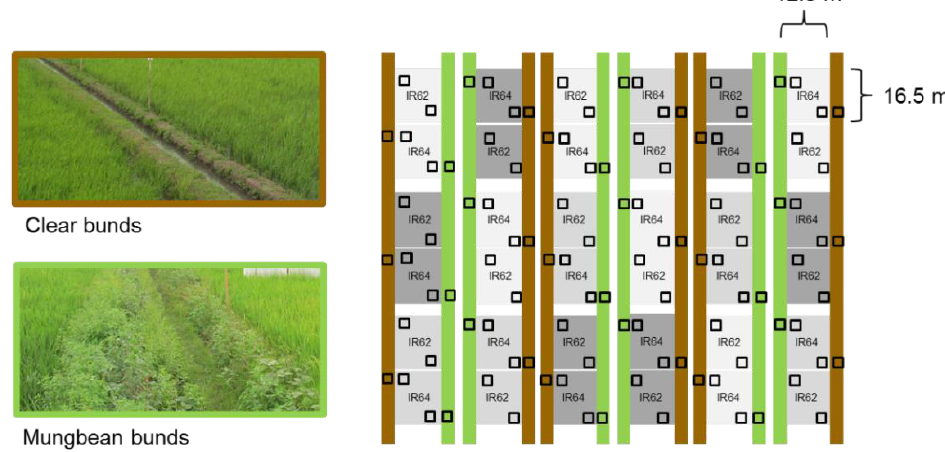
Figure 2. Field set-up during the 2013 wet season indicating fertilizer levels (light grey = 0 added nitrogen, medium grey = 60 Kg ha − 1 of added nitrogen, dark grey = 150 Kg ha − 1 of added nitrogen) and bund treatments (brown = clear bunds, light green = mung bean bunds). Nitrogen-treatment plots were subdivided into IR62 (resistant) and IR64 (susceptible / tolerant) rice varieties. Squares indicate approximate sampling points. Photographs indicate the appearance of bunds during rice crop growth. Note the more rapid growth of the mung bean plants on the left, high-nitrogen bund compared with the right, low-nitrogen bund in the lower photograph.